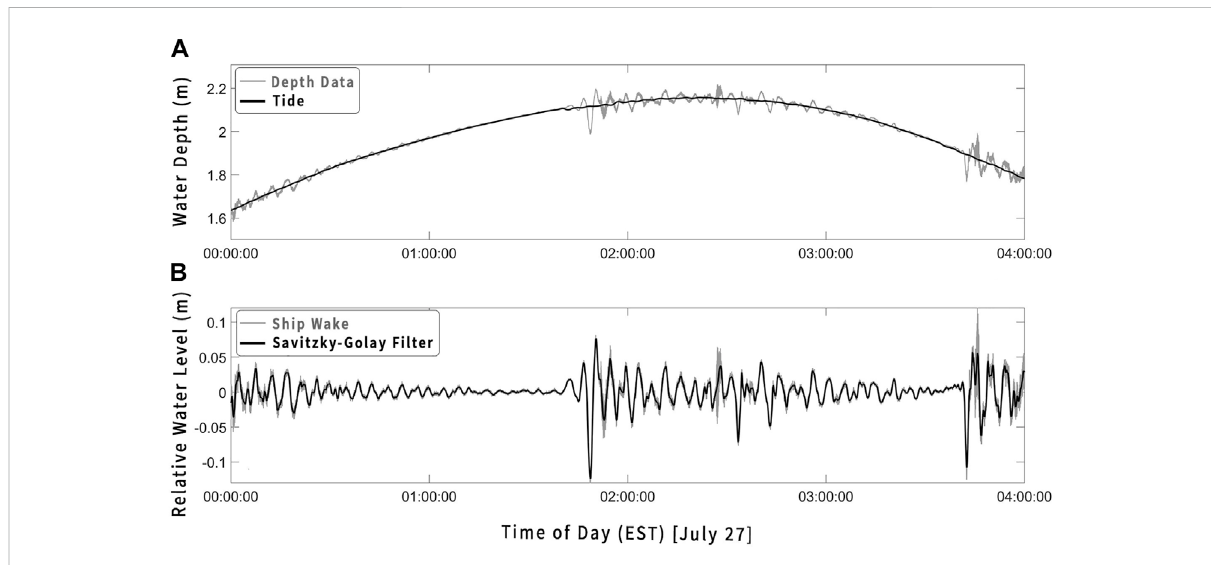
FIGURE 3 (A) Raw depth overlaid with computed tidal signal. (B) Depth data after tidal removal overlaid with Savitzky-Golay fi ltered